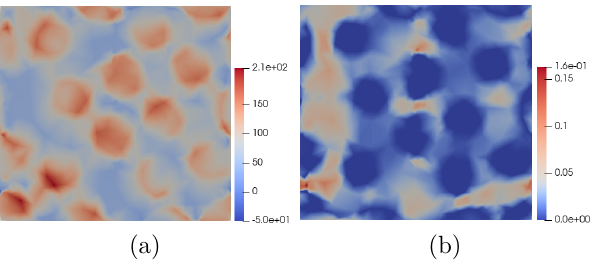
Figure 18. Carbon composite with maximal stiffness, time = 50 s: a) Shear stress [MPa], b) creep strain.